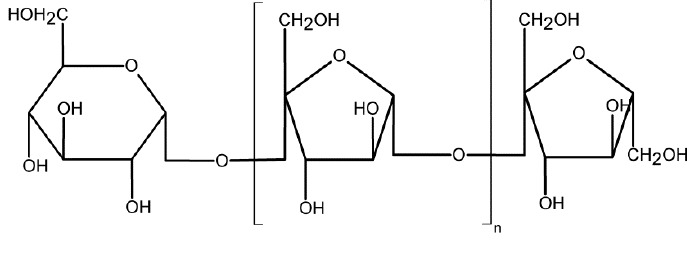
Figure 1. Inulin